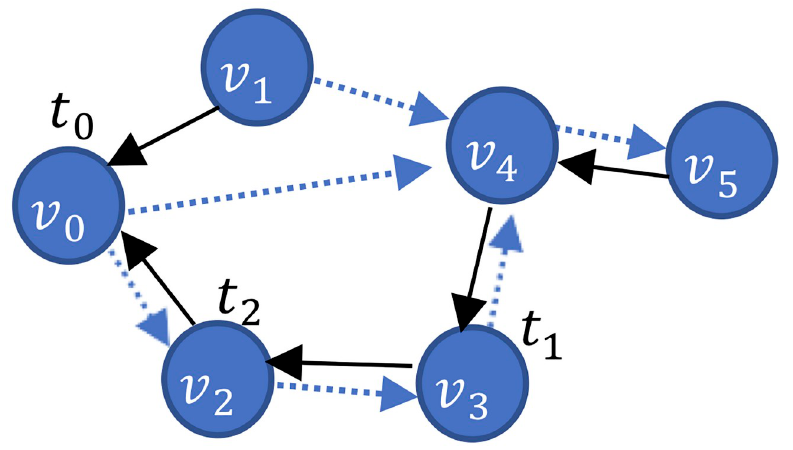
Fig 2. An activity network with a social network illustrating global